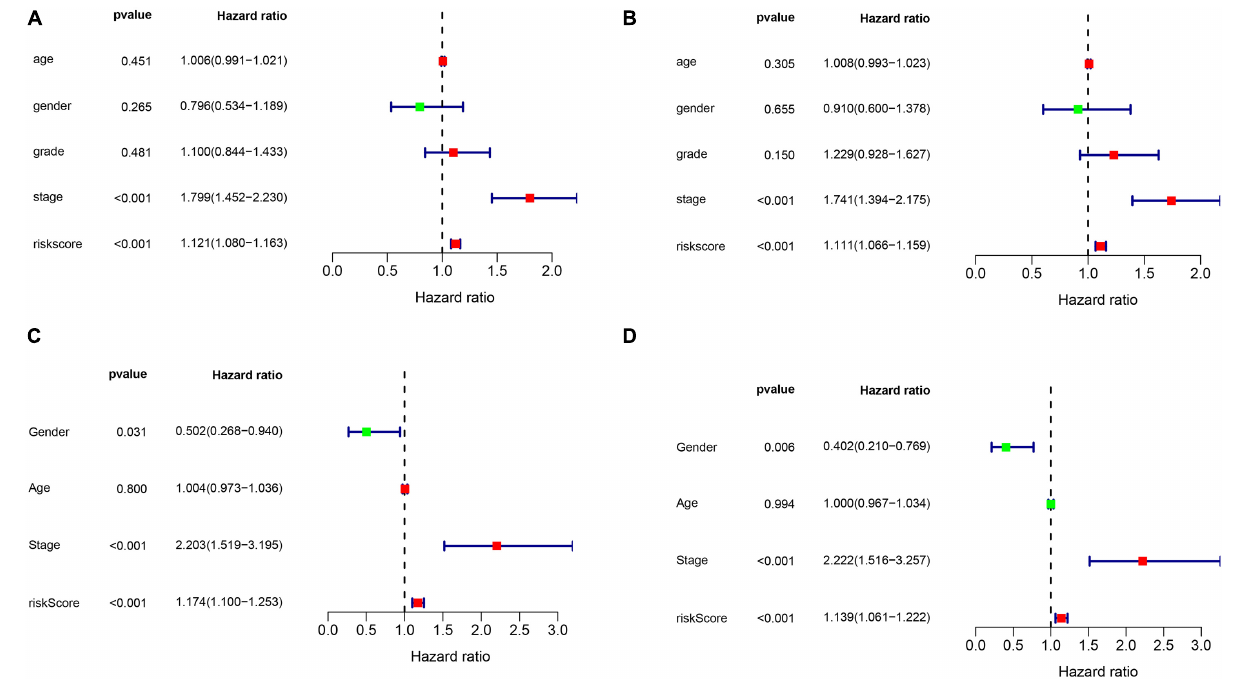
Frontiers in Genetics |